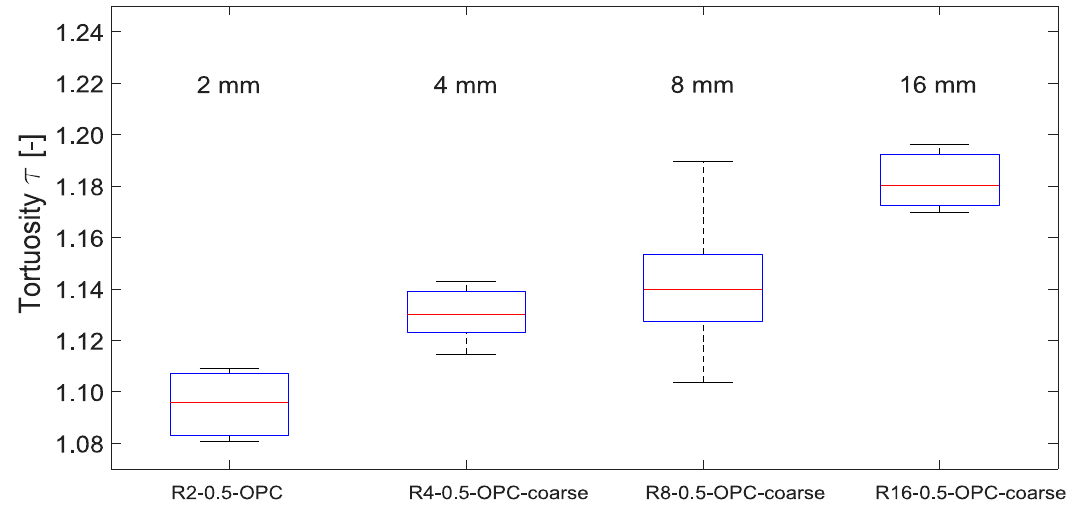
Figure 9. Effect of the maximum aggregate size on tortuosity (bottom and top edge of a box indicate the 25th and 75th percentiles, the band inside a box is the median, whiskers extend to the minimum and maximum data point within the 1.5 times interquartile range).